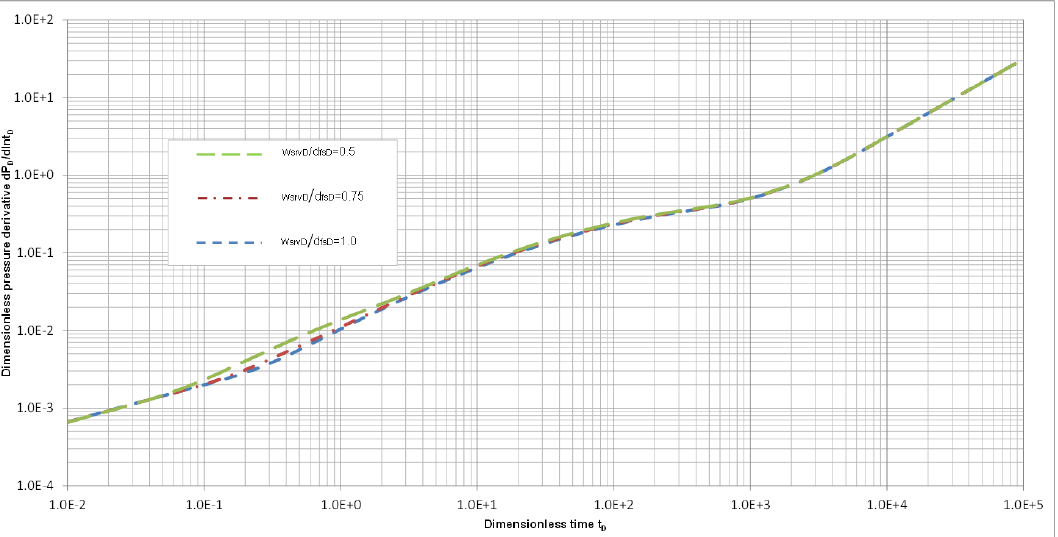
Figure 21. Pressure response of a fractured, horizontal well under a different ratio of local SRV width and space between fractures as 𝑘 1 /𝑘 2 = 20 , 2𝐿 𝑓𝐷 /𝑌 𝑒𝐷 = 0.1 , 𝑋 𝑒𝐷 = 200 , and 𝑌 𝑒𝐷 = 100 .